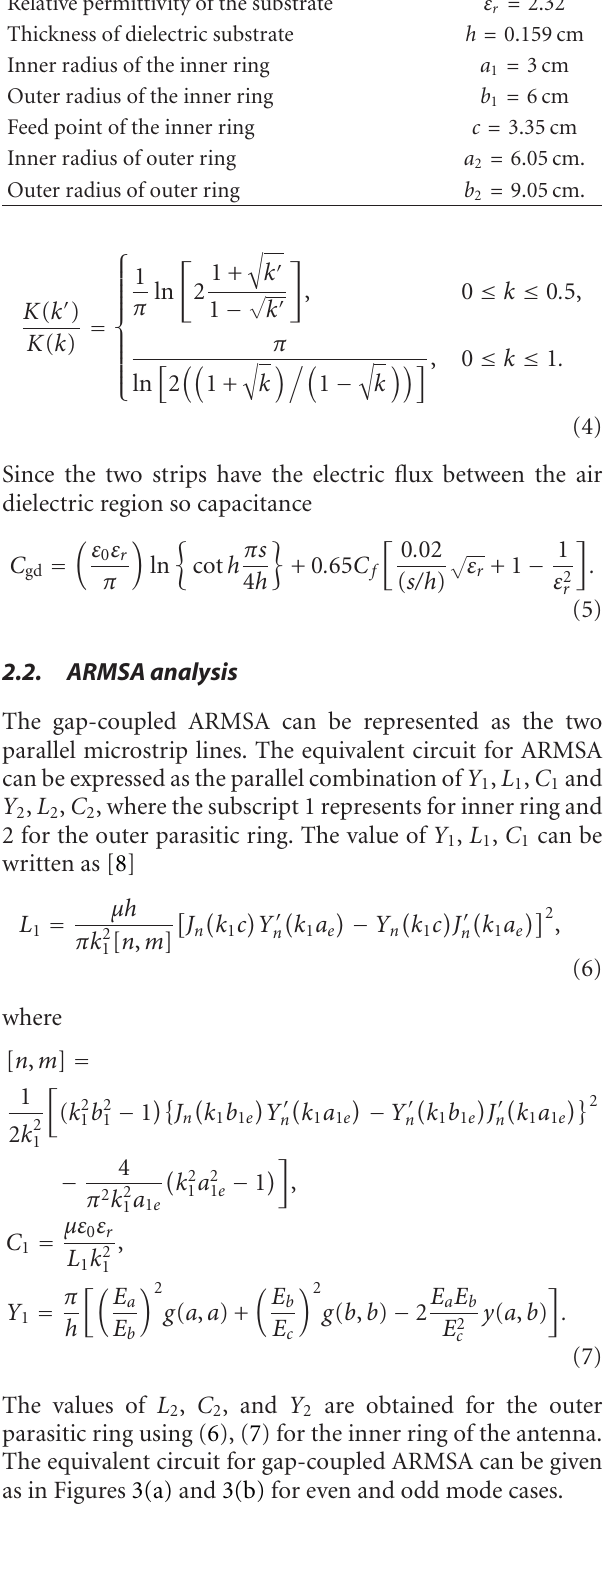
Table 1: Designing specification of annular ring microstrip an- tenna. Parameters Value Substrate material used RT Duroid 5870 E ff ective relative permittivity ε e ff =